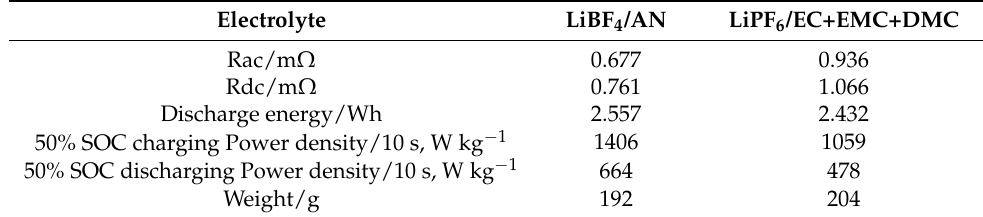
Table 1. The performance of AC/LTO LIC-based different electrolytes.